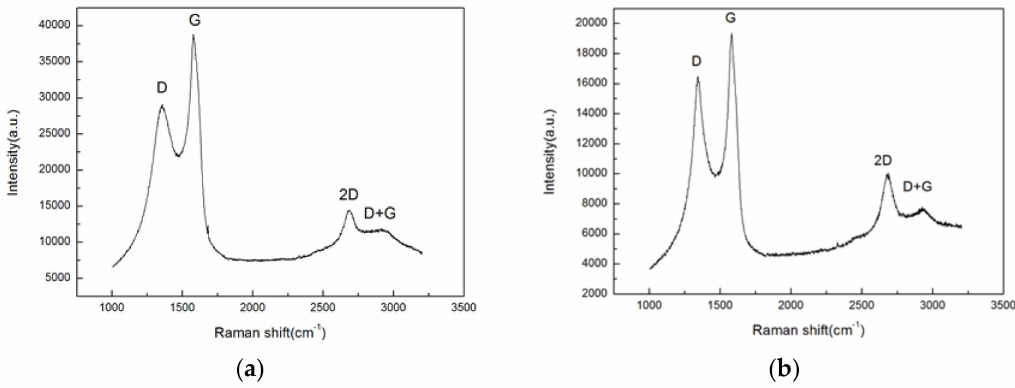
Figure 7. Raman results for ( a ) graphene before friction test, ( b ) the friction surfaces lubricated by the 5CB+0.15 wt.% G